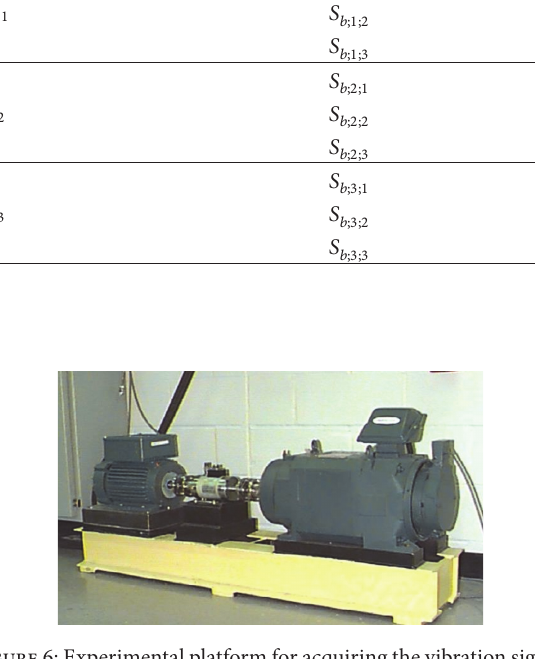
Figure 6: Experimental platform for acquiring the vibration signals of rolling